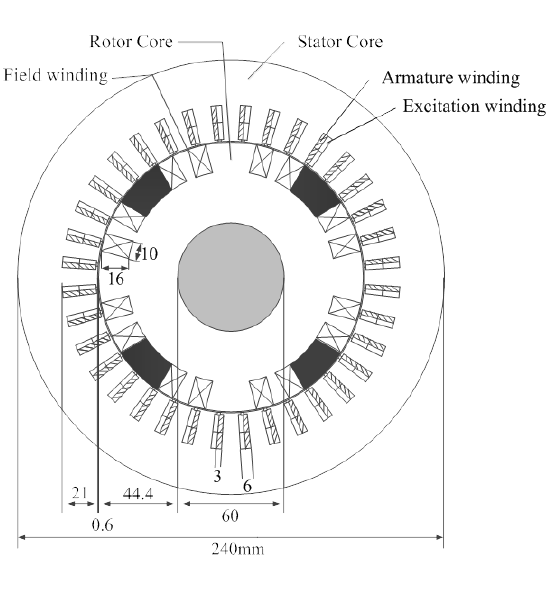
Figure 4. Generator model.